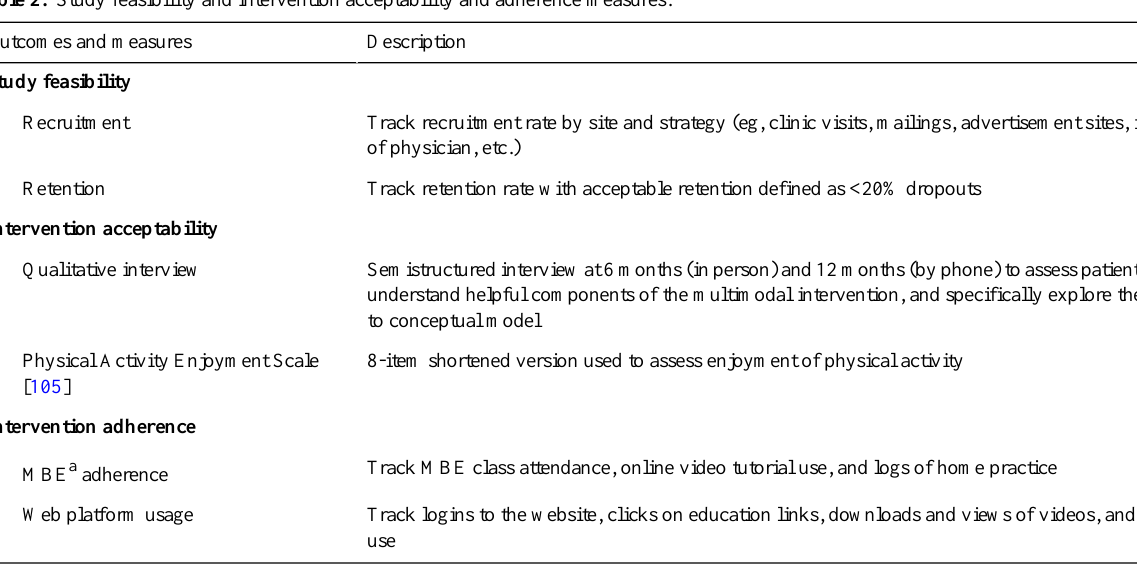
Table 2. Study feasibility and intervention acceptability and adherence